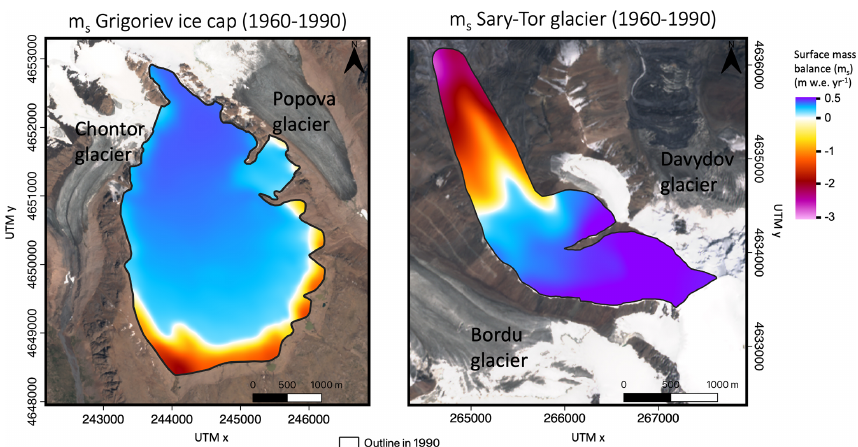
Figure 4. Average surface mass balance ( m s ; mw.e.yr 1 ) of the Grigoriev ice cap and the Sary-Tor glacier for the mean 1960–1990 climatic conditions. The background is a Sentinel-2 image from 26 July